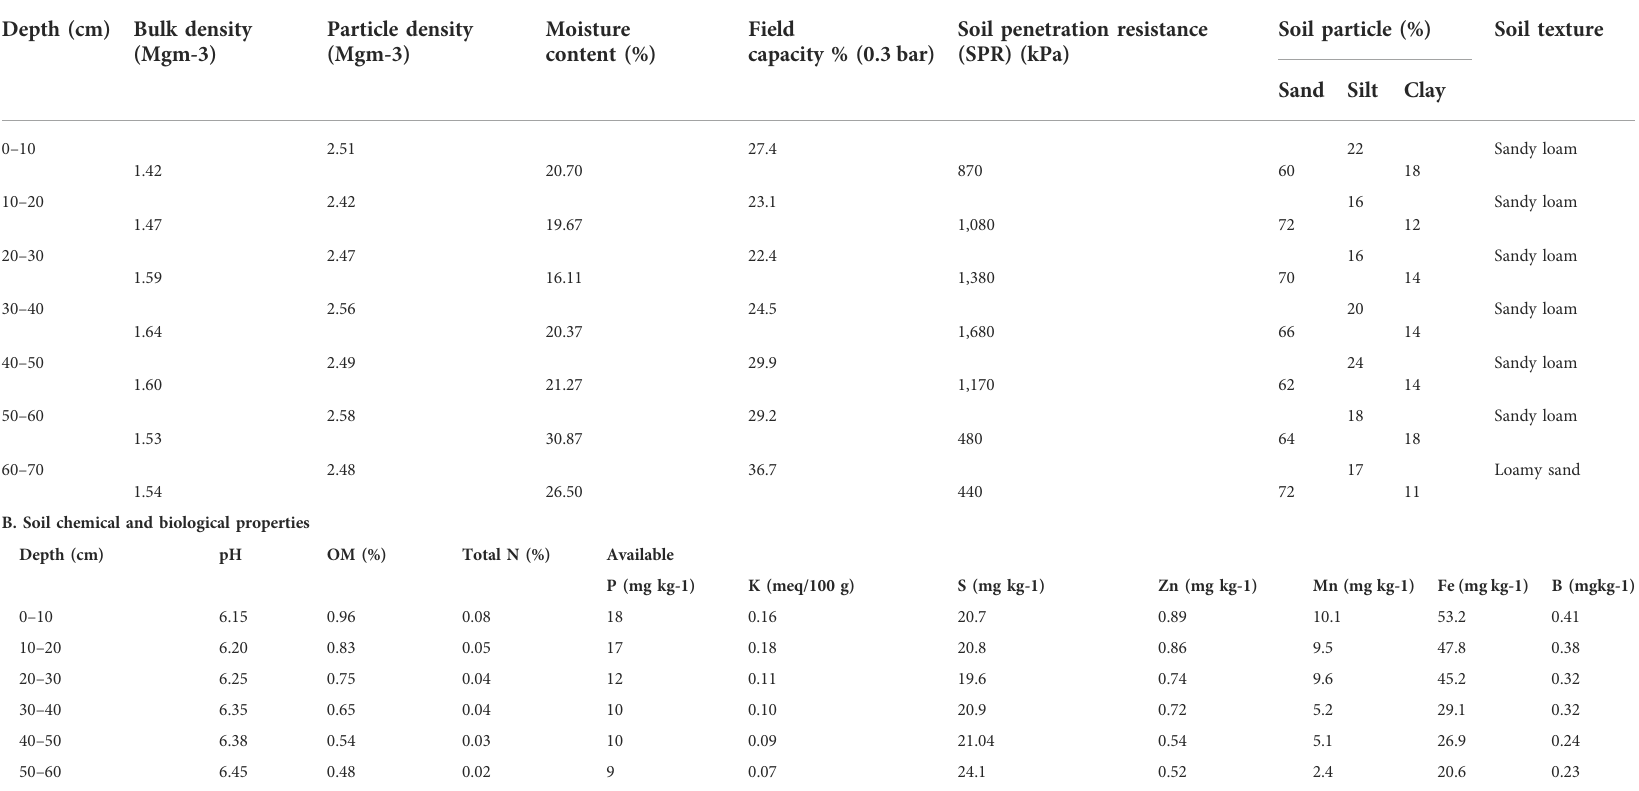
TABLE 1 The initial status of soil properties at the experimental